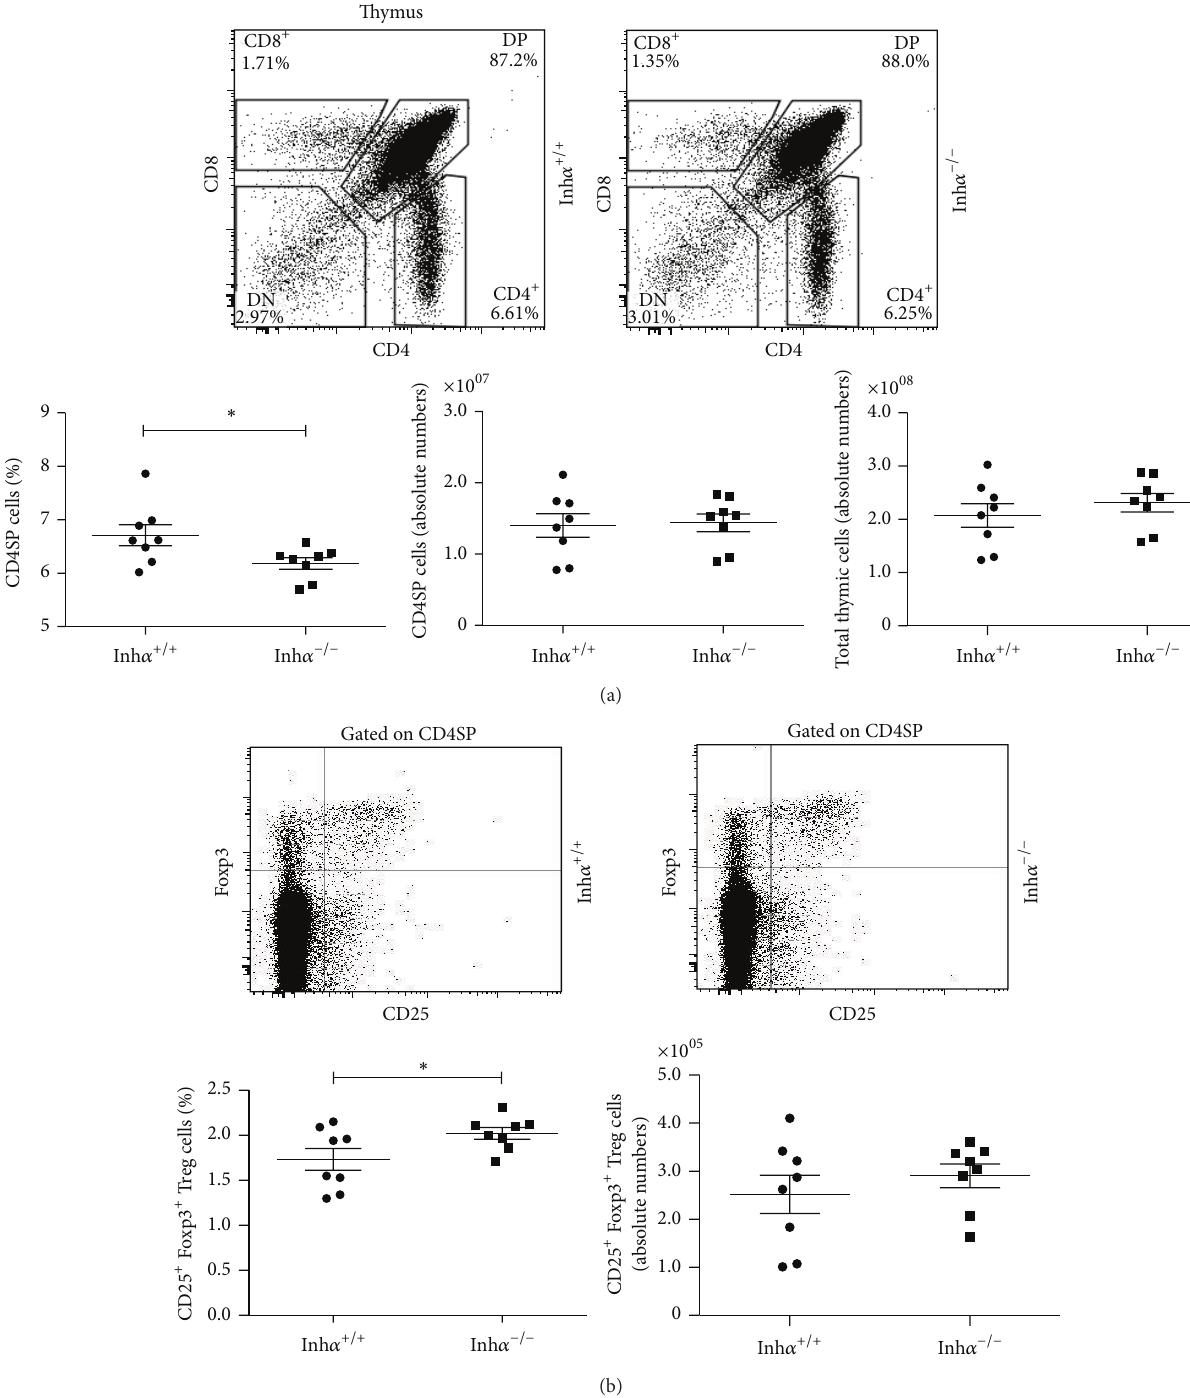
Figure 6: Decreased percentage of CD4SP and increased levels of Tregs in the thymus of Inh 𝛼 −/− mice. Thymocytes from 2-week-old Inh 𝛼 +/+